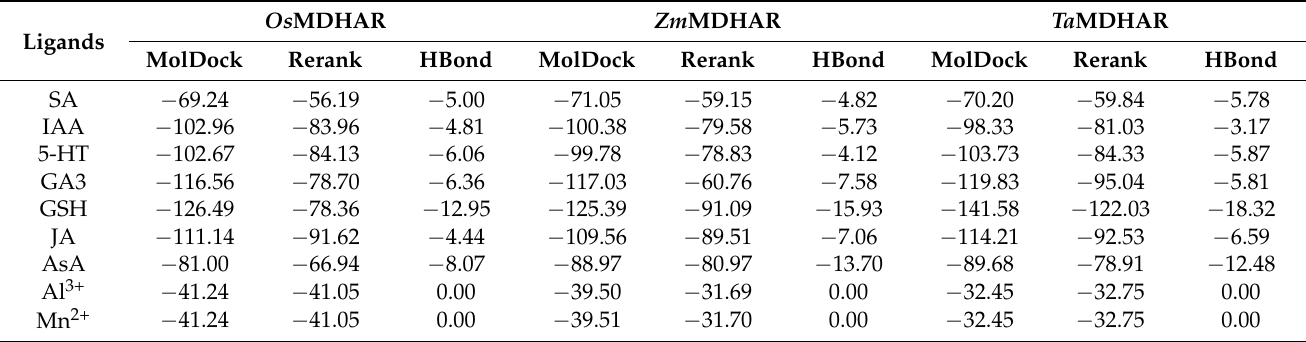
Table 3. Docking scores (MolDock, Rerank and Hydrogen bond) of MDHAR of rice, maize and wheat with different ligands, including